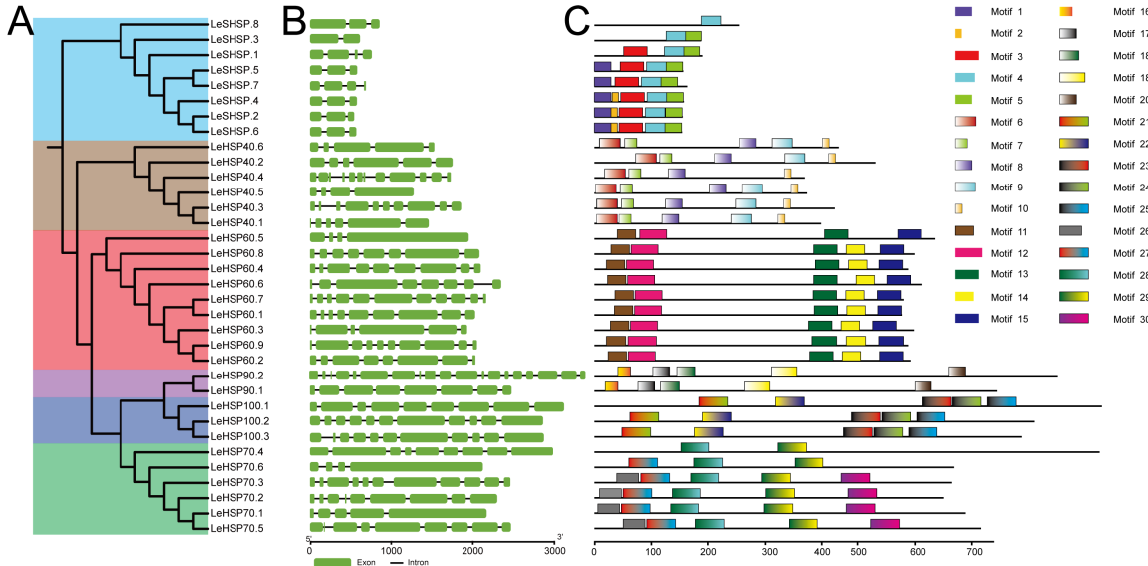
Figure 1. Phylogenetic relationship, gene structure, and conserved motif analysis of LeHSP genes. ( A ) Phylogenetic tree of 34 LeHSP proteins. Azure, brown, red, purple, blue, and green colors represent the LeSHSP , LeHSP40 , LeHSP60 , LeHSP90 , LeHSP100 , and LeHSP70 genes, respectively. ( B ) Exon/intron organization of LeHSP genes. Green boxes represent exons and black lines with the same length represent introns. ( C ) Distributions of conserved motifs in LeHSPs. The conserved motifs of 34 proteins were identified and visualized by MEME.